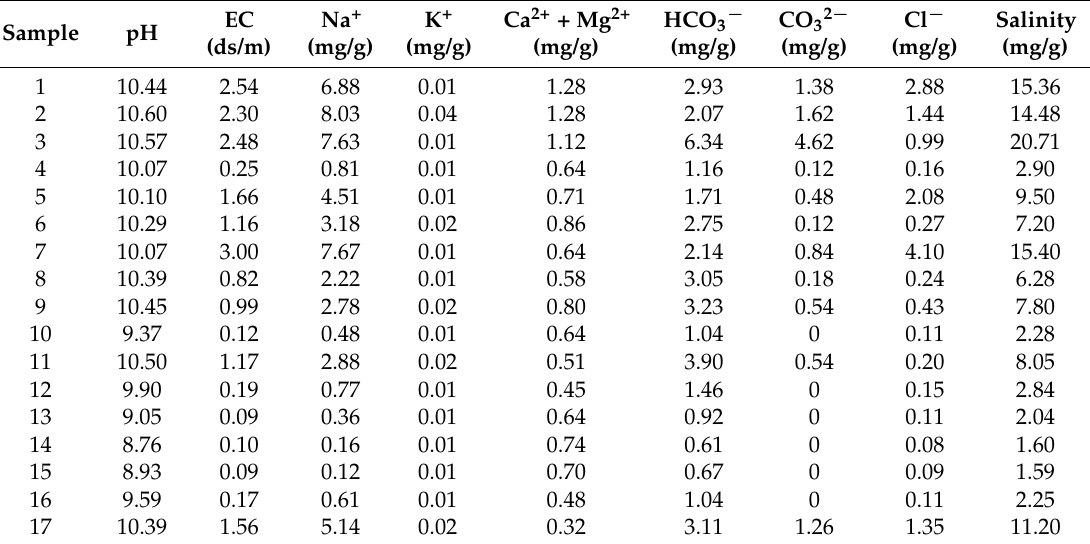
Table 1. Physicochemical properties of soil samples.